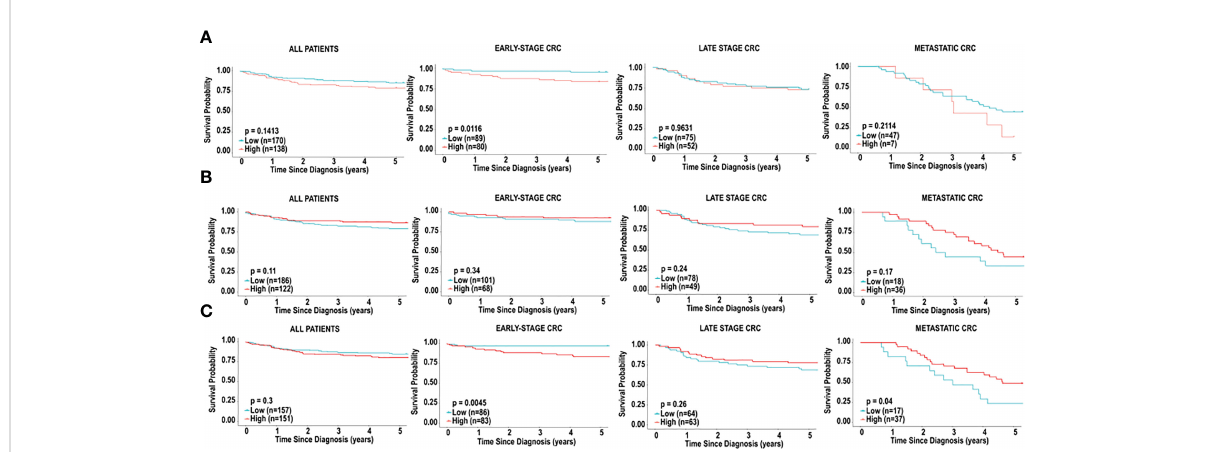
FIGURE 5 Immune cell in fi ltration and survival analysis of CRC based on CD8 + T cells. (A) Kaplan-Meier curve for overall fi ve-year survival based on relative cell fractions of CD8 + T cells, based on CIBERSORT analysis for all patients, patients with early-stage CRC, late-stage CRC and metastatic CRC. (B) Kaplan- Meier curve for overall fi ve-year survival based on relative cell fractions of CD8 + T cells, based on xCell analysis for all patients, patients with early-stage CRC, late-stage CRC and metastatic CRC, based on MCP-counter analysis. (C) Kaplan-Meier curve for overall fi ve-year survival based on relative cell fractions of CD8 + T cells, based on xCell analysis for all patients, patients with early-stage CRC, late-stage CRC and metastatic CRC, based on MCP- counter analysis. Groups with high and low cell numbers were compared with log-rank